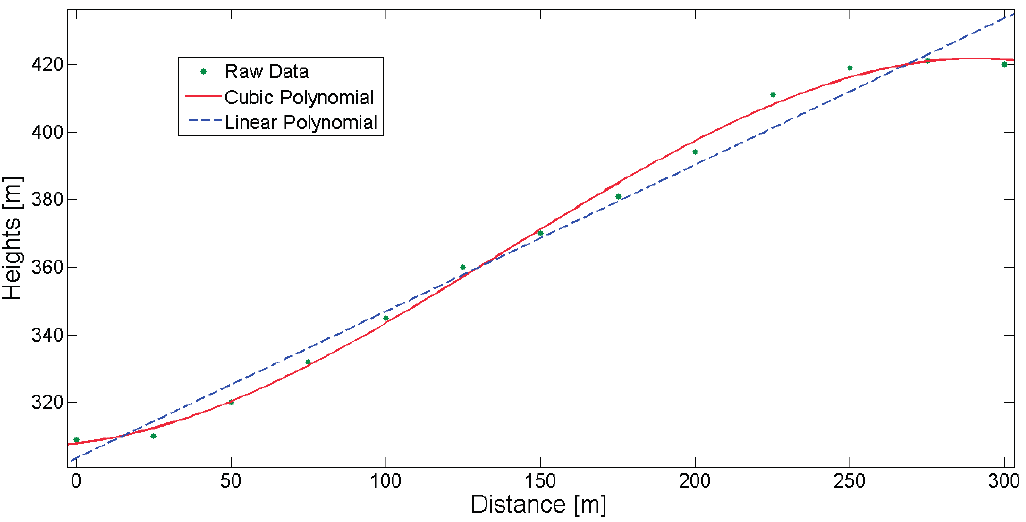
Figure 4. Best-fitting linear and cubic polynomial for given height data (section view).